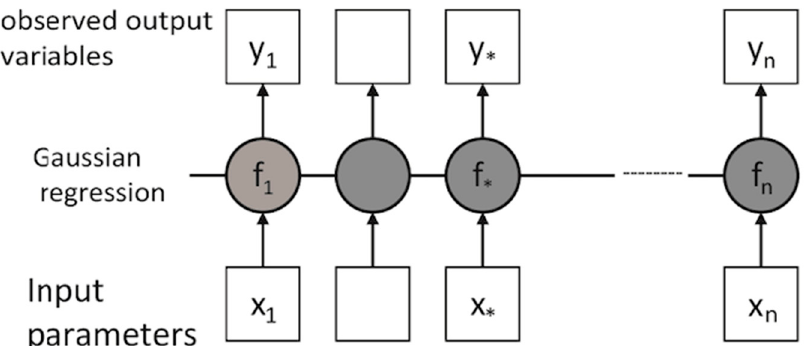
Figure 8. The graphical illustration of GPR (figure redrawn based on discussion in Reference [86]). The box represents observed variables which are uncertainly independent of the other corresponding value of f , while the circles show unknown variables [86].